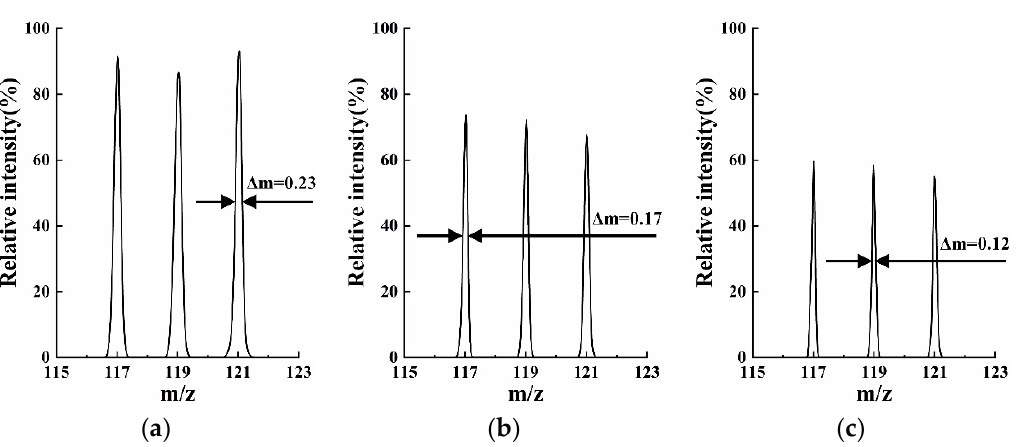
Figure 7. Mass spectrum and FWHM of the 2-slit model ( r x = 1.4 mm, r y = 2.5 mm) at different scan rate: ( a ) 2250 Th/s; ( b ) 1250 Th/s; ( c ) 800 Th/s. The corresponding resolutions were 517, 670, and 1017.